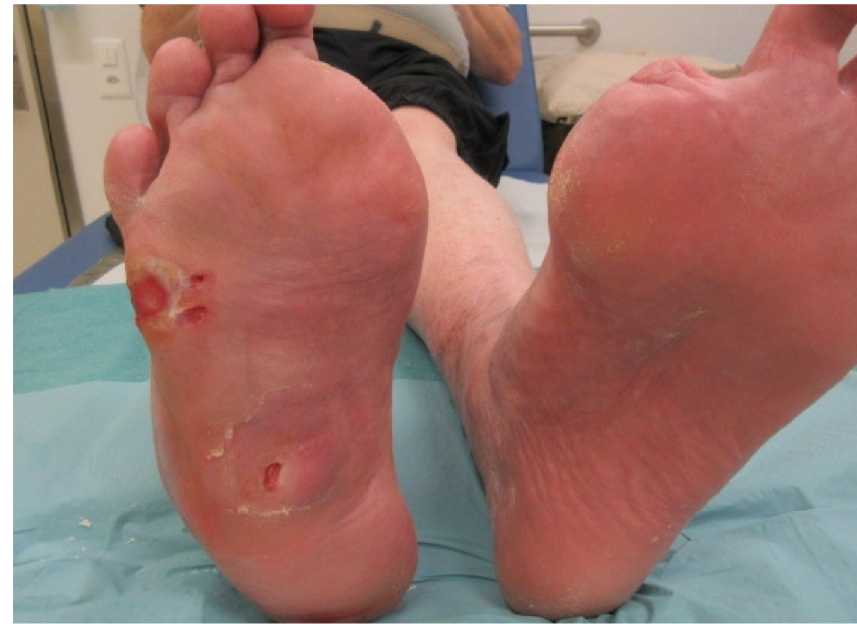
Figure 1. Infected ulceration of the lateral edge of the right foot in a man with diabetic Charcot neuro-osteoarthropathy (with previous amputations of both great toes). Note the collapse of the midfoot, with consequent pressure-related ulcerations, a long-standing clinical problem. The ulcer on the lateral foot recently became infected and was found to have underlying bone involvement. As shown in this photograph, the manifestations of infection in a diabetic foot ulcer may be minimal at the beginning, but can progress rapidly. There is somewhat more pronounced erythema and induration proximal and dorsal to the ulcer. The patient noticed new pain at the site and a sudden change in the color of the foot. He had no fever or visible purulent secretions. This case illustrates that: infection in the diabetic foot is almost always due to underlying problems (such as foot deformity or peripheral neuropathy); even deep infection may present with initially relatively minimal signs and symptoms; clinician’s should consider osteomyelitis in every diabetic patient with a foot ulceration. (Photograph obtained with permission of the patient.).